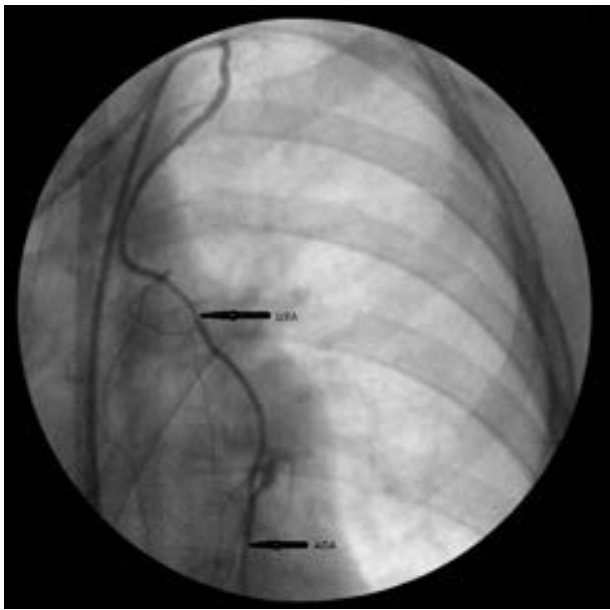
Fig. 3 – Intraoperative coronary angiogram of anterior descending artery (ADA) grafting using left internal thoracic artery (LITA) in a 7-year-old child with Kawasaki disease.